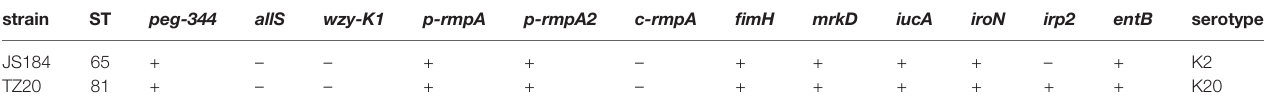
TABLE 1 | Traits of con fi rmed bla KPC (+)-HvKP strains.